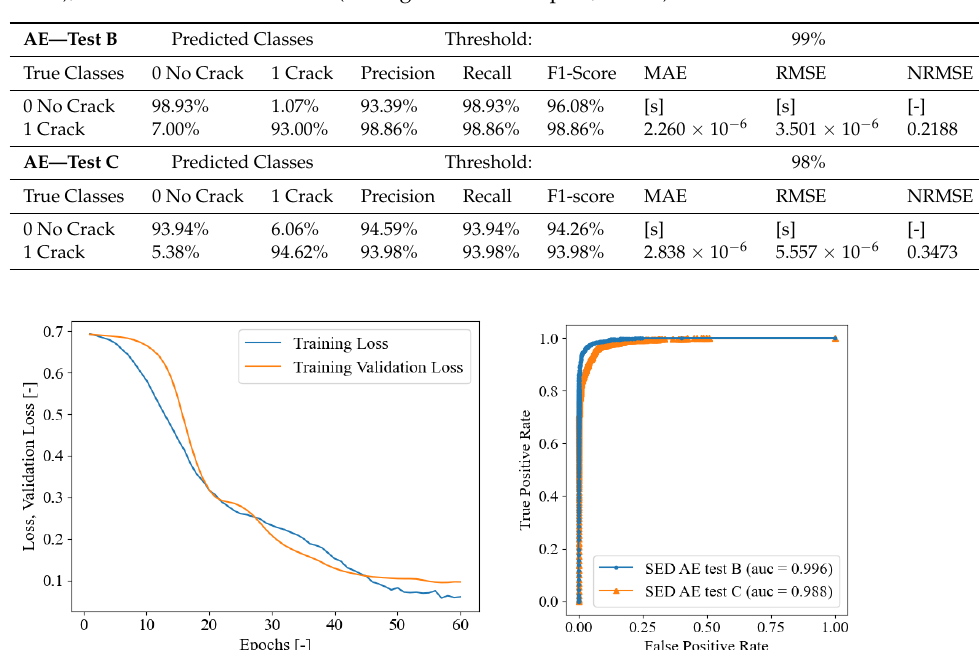
Table 4. Confusion matrix and classification metrics for SED trained on AE only (training set: PLB